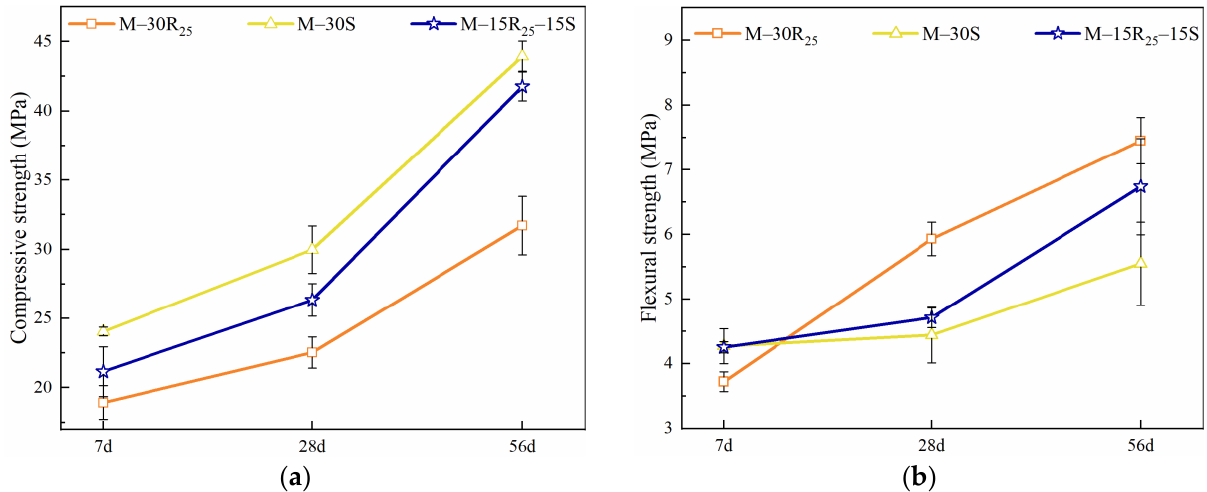
Figure 3. Mechanical strength of eco-efficient mortar mixtures in Series A: ( a ) compressive strength, ( b ) flexural strength.